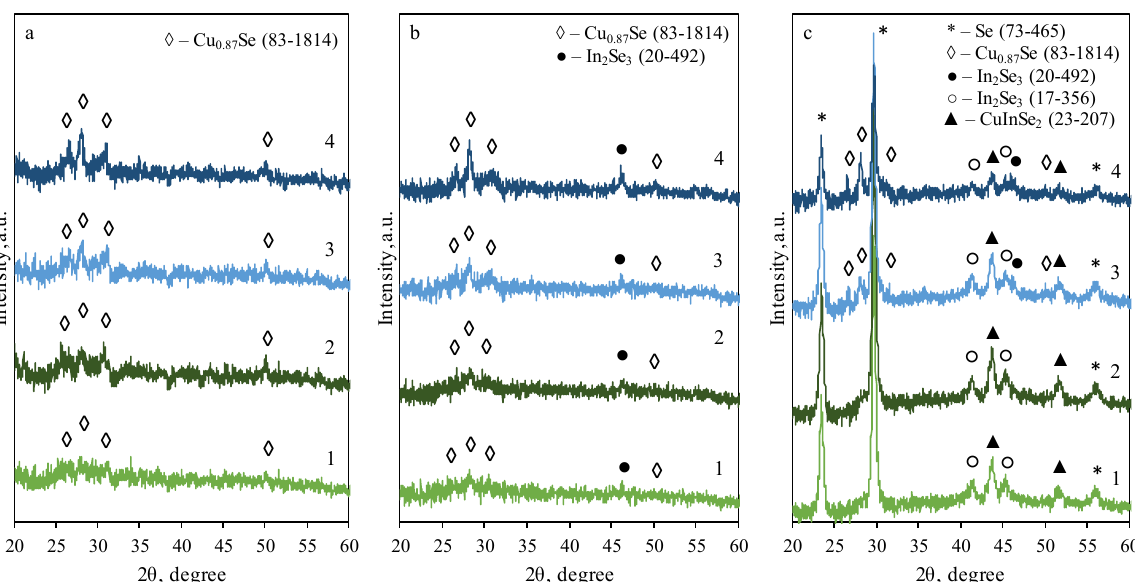
Figure 2. XRD patterns of Cu x Se and In-incorporated Cu x Se films on glass substrate: ( a ) treated with copper(II/I) ion solution, ( b ) treated with indium(III) salt solution, ( c ) annealed in nitrogen atmosphere. Treatment with copper(II/I) ion solution: 1—10 min at 40 °C; 2—20 min at 40 °C; 3—5 min at 60 °C; and 4—10 min at 60 °C.